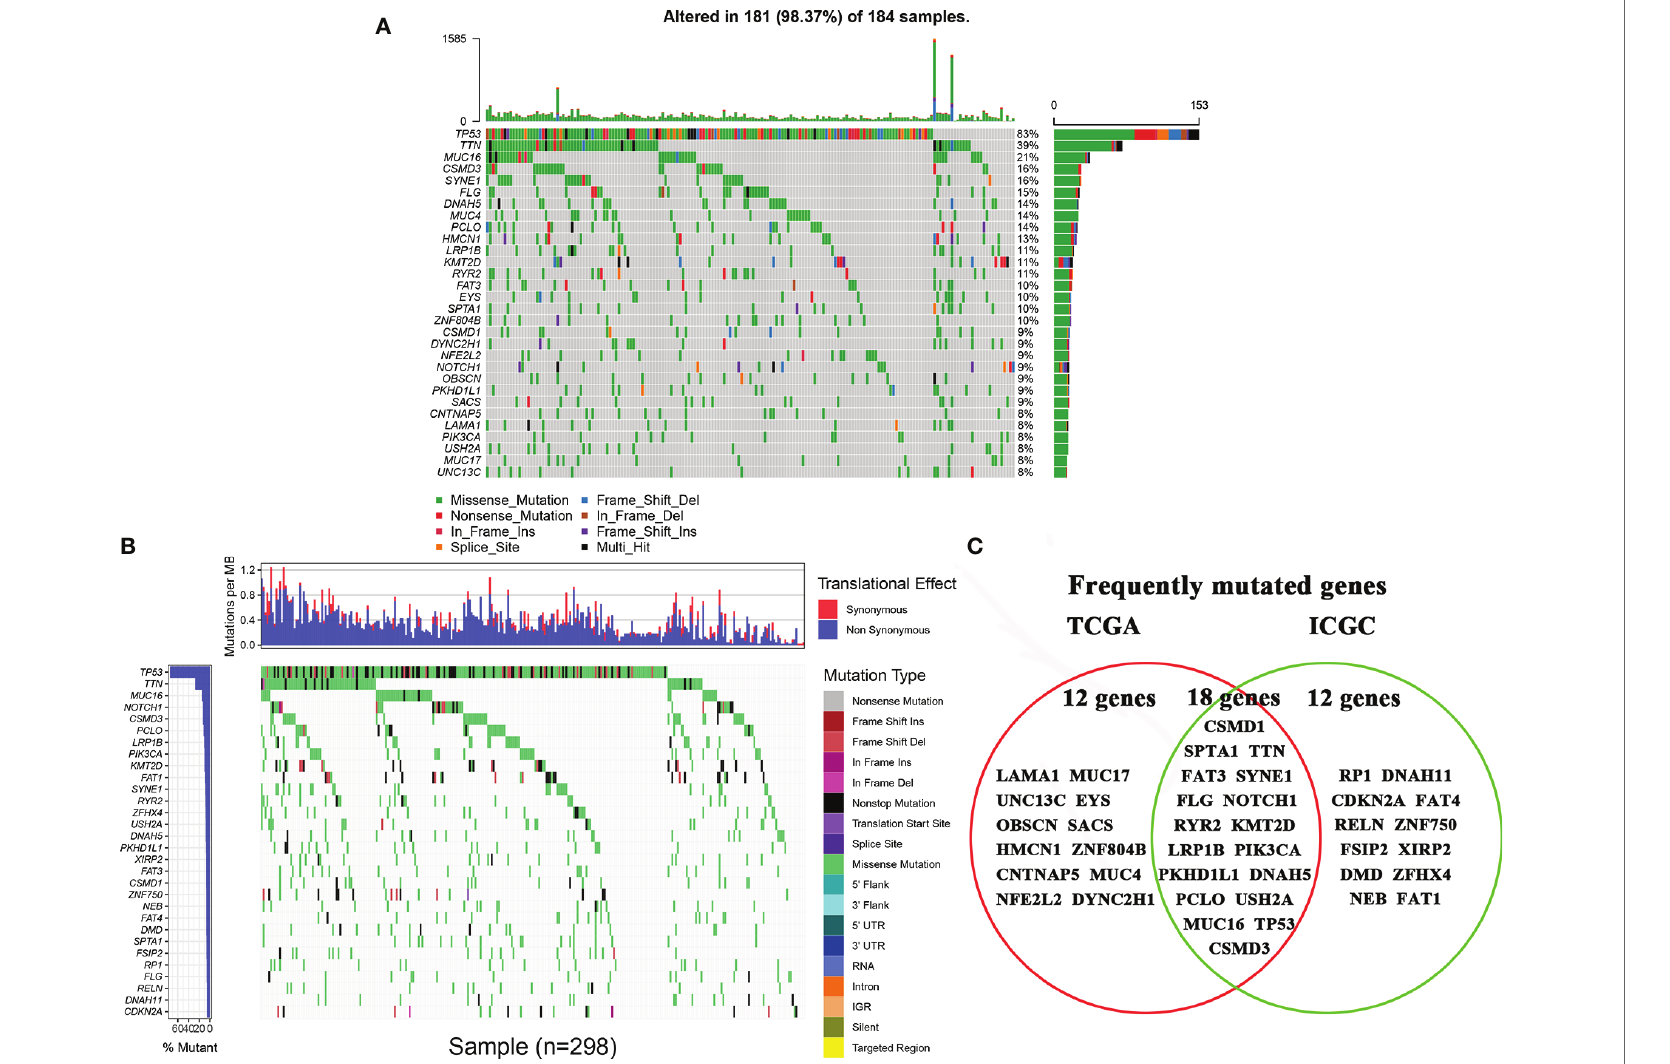
FIGURE 1 | Landscapes of frequently mutated genes in esophageal cancer. (A) Oncoplot displaying the landscapes of frequently mutated genes in ESCA from the TCGA database. Genes are ordered according to their mutation frequency (left panel), and different mutation types were presented as indicated by the annotation bar (bottom). (B) Waterfall plot displaying the landscapes of frequently mutated genes in ESCA from the ICGC database. Genes are ordered according to their mutation frequency (left panel), and different mutation types were presented as indicated by the annotation bar (right panel). (C) Venn diagram displaying the common frequently mutated genes that were both of the top 30 high-frequency mutated genes in the TCAG database and ICGC